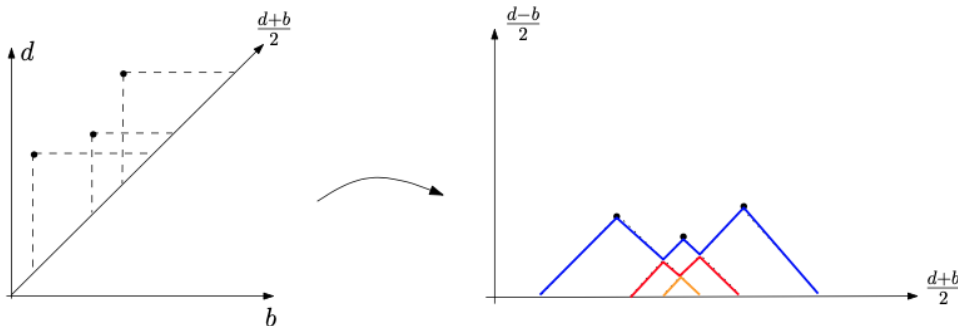
Figure 5. An example of transformation from a persistence diagram to the persistence landscapes [43]. Left: the horizontal axis in the persistence diagram is the birth time, while death time is on the vertical axis. Right: the horizontal axis is the average of the homologies’ birth death event times, and vertical axis for ( d − b )